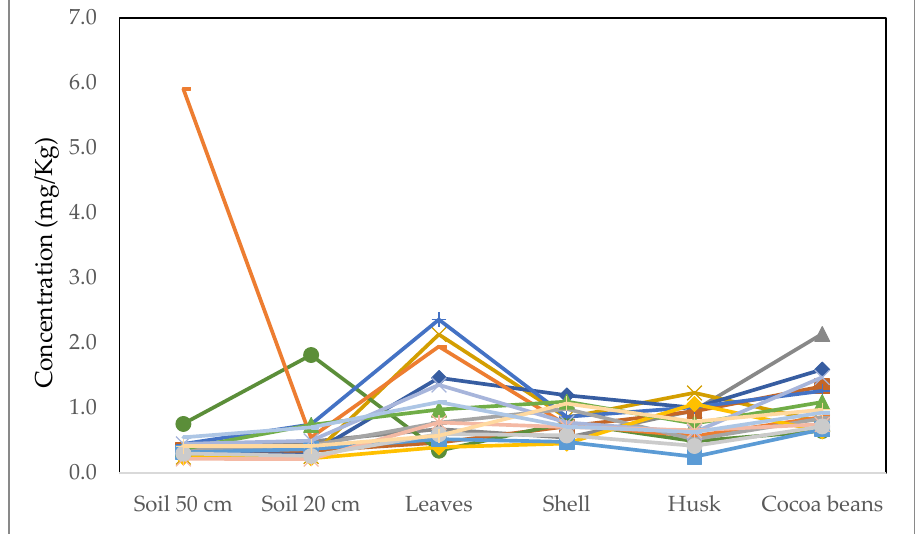
Figure 7. Zn content in soil and different parts of cocoa plant, the concentration is observed for 18 samples. The limit is 99.4 mg/Kg, and no sample exceeds this level.